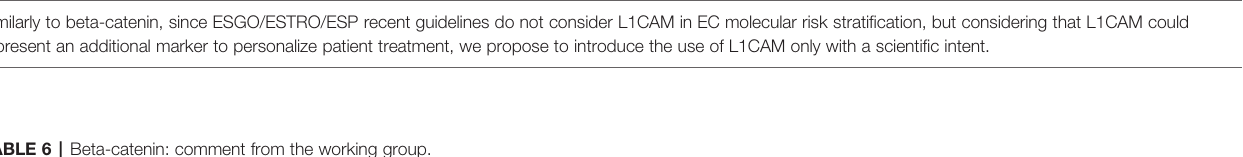
TABLE 6 | Beta-catenin: comment from the working group.